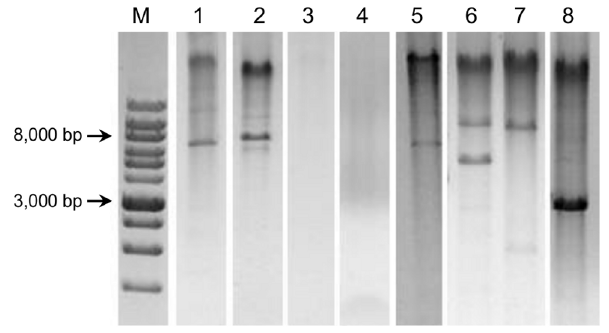
Figure 3. Restriction results of the Rolling Circle Amplification (RCA) products. Lanes: 1 . HPV6-positive sample digested with BamHI: the linearized genome of the expected size for the episomal DNA (7902 bp) is visible; 2 . HPV16-positive sample digested with BamHI: the linearized genome of the expected size for the episomal DNA (7905 bp) is visible; 3 . HPV16-positive sample digested with BamHI: no restriction fragments are observed, suggesting the integration of the viral genome; 4. Linear Array-negative sample digested with BamHI: no restriction fragments are visible; 5 – 8. Linear Array-negative samples digested with BamHI: one or more bands are detected, suggesting the presence of other circular DNA viruses. M. Molecular marker DM013- R500 (Gene-DireX,